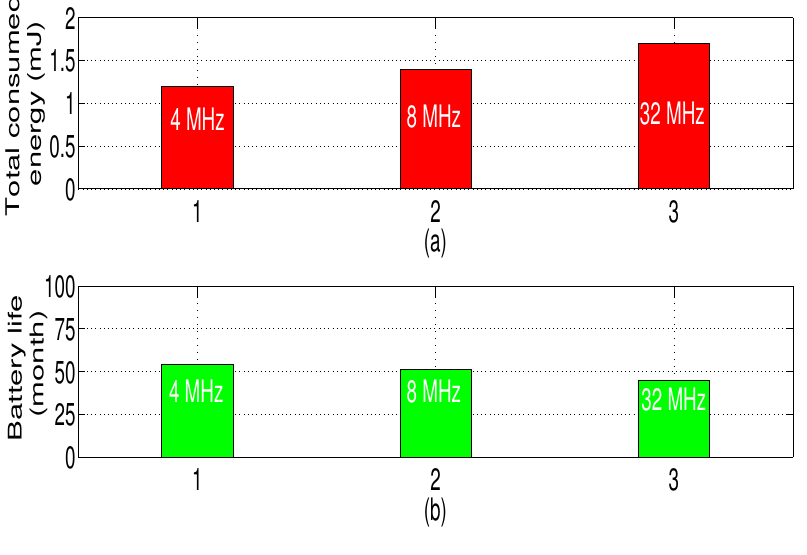
Figure 22. Total energy consumption for different microcontroller frequencies ( a ), Battery life ( b ) (Mode 3, Scenario